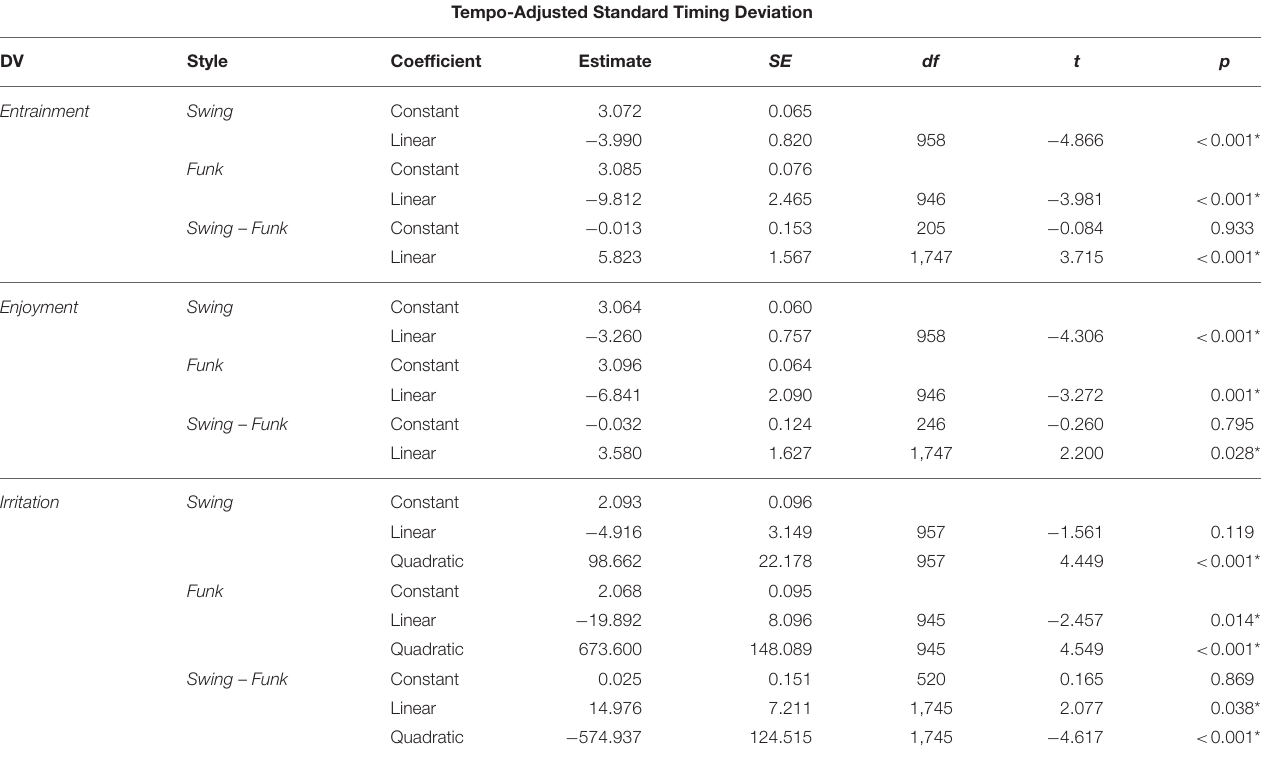
TABLE 3 | Regression models for the relationship between Tempo-Adjusted STD and Entrainment , Enjoyment , and Irritation for Swing , Funk , and the difference between Swing and Funk